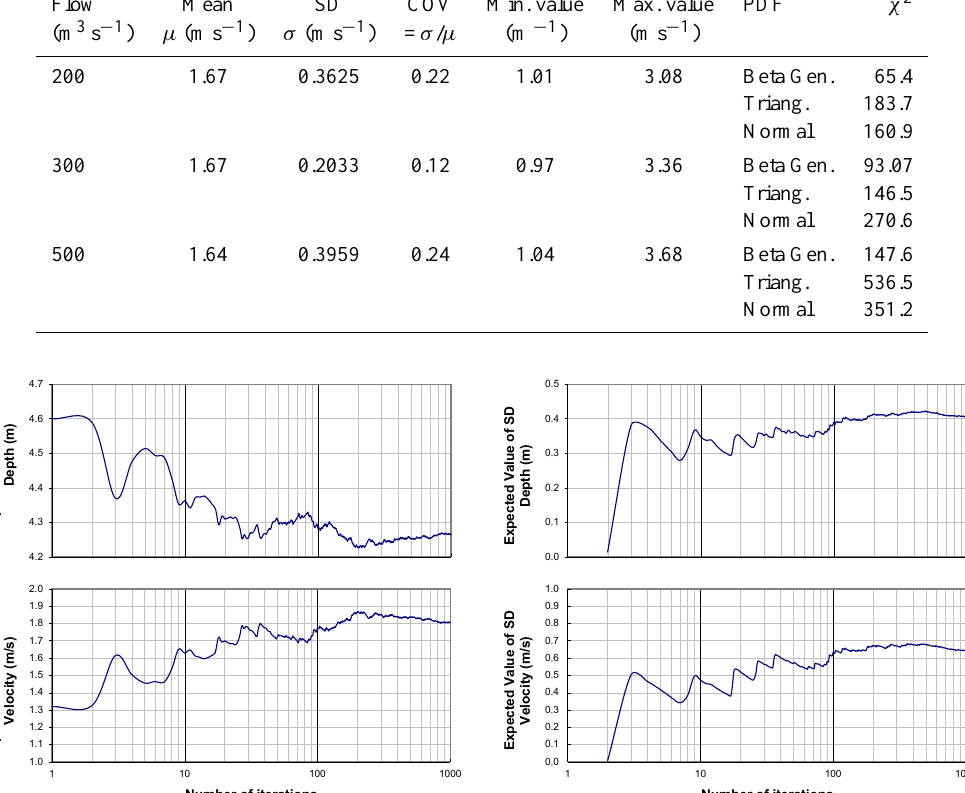
Table 6. Uniform flow model. Adaptation of PDFs to velocity with triangular distributions for n i (1000 simulations). Flow Mean SD COV Min. value Max. value PDF